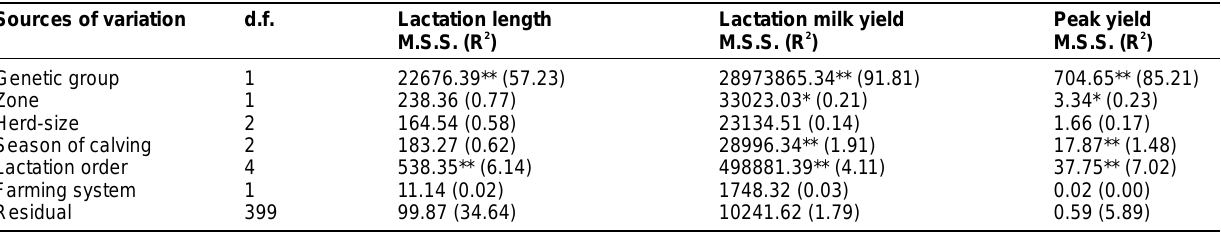
Table-1. Least square analysis of variance showing effects of genetic and non-genetic factors on lactation length, lactation milk yield and peak yield of animals in and around Gondar (Ethiopia). Sources of variation